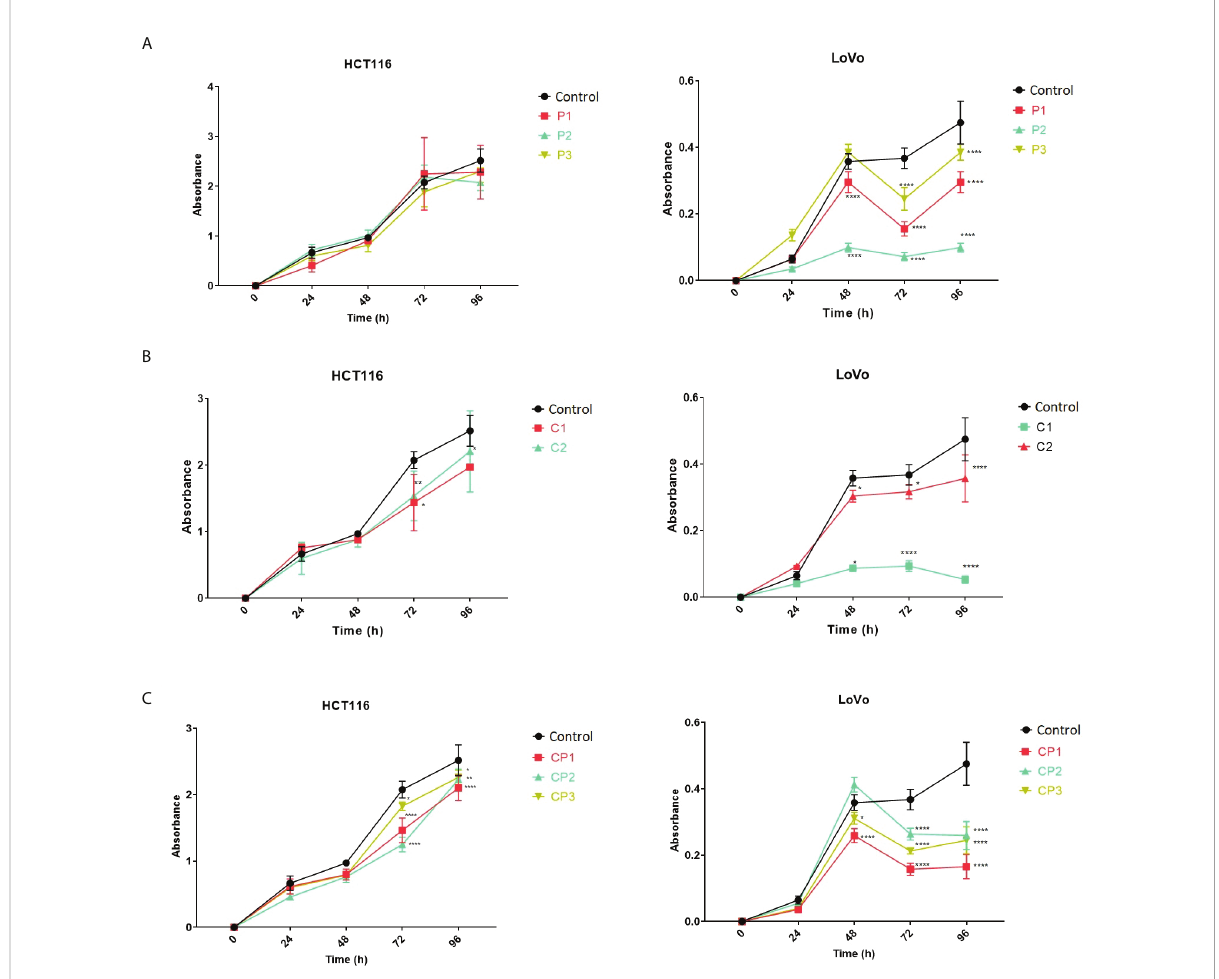
FIGURE 5 LoVo and HCT116 cell growth in normal and PVT1 and CASC11 knocked down forms. (A) Cells with PVT1 expression perturbation, P1: PVT1 sgRNA pair 1, P2: PVT1 sgRNA pair 2, and P3: PVT1 sgRNA pair 3, and control cells with non-targeting gRNA. (B) Cells with CASC11 expression perturbation, C1: CASC11 sgRNA pair 1, C2: CASC11 sgRNA pair 2, and control: non-targeting gRNA. (C) Concomitant PVT1-CASC11 perturbation, CP1: CASC11-PVT1 sgRNA pair 1, CP2: CASC11-PVT1 sgRNA pair 2, CP3: CASC11-PVT1 sgRNA pair 3, and control: non-targeting gRNA. Cell growth was signi fi cantly decreased 48h after interference with PVT1 and CASC11 expression in LoVo cells. *P<0.05, **P<0.01,